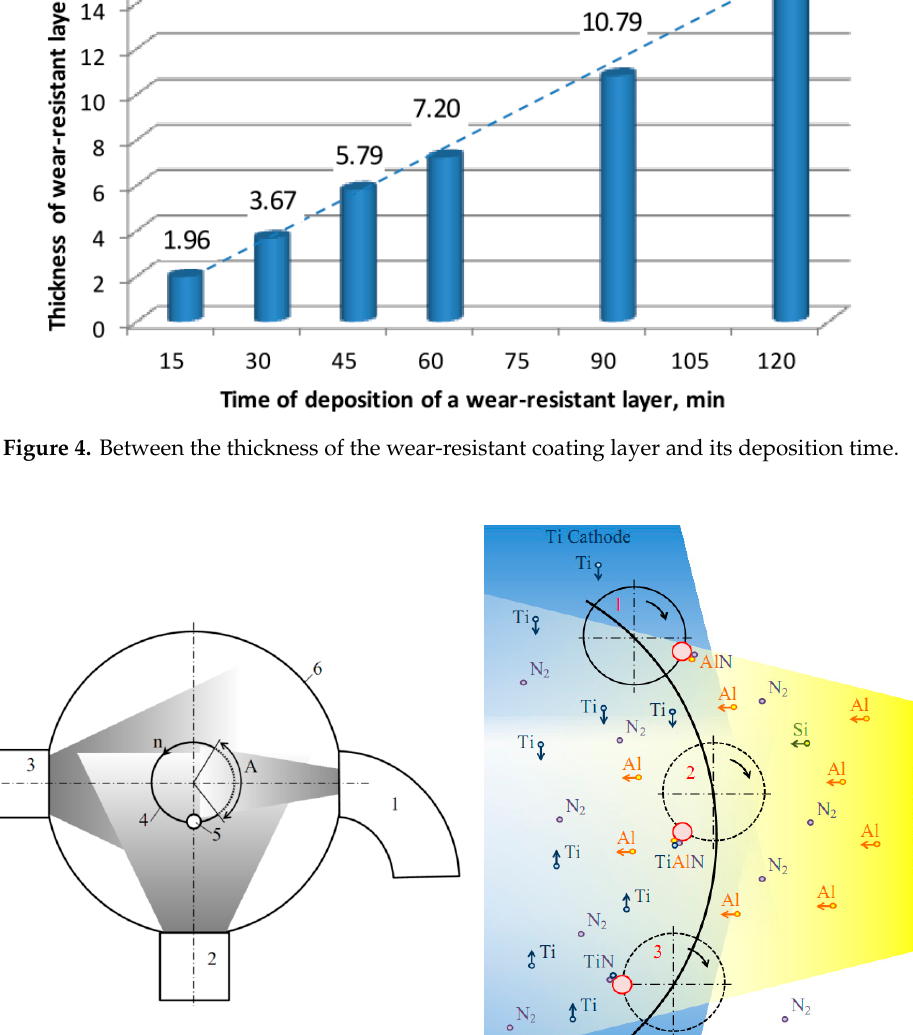
Figure 4. Between the thickness of the wear-resistant coating layer and its deposition time.